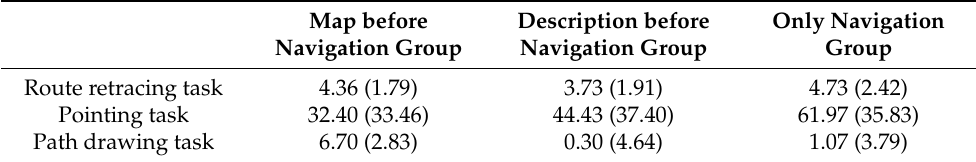
Table 1. Means and standard deviations (in brackets) of performance in route retracing (number of errors), pointing (degrees of error) and path drawing (number of correct turns) by group. Map before Description Navigation Group